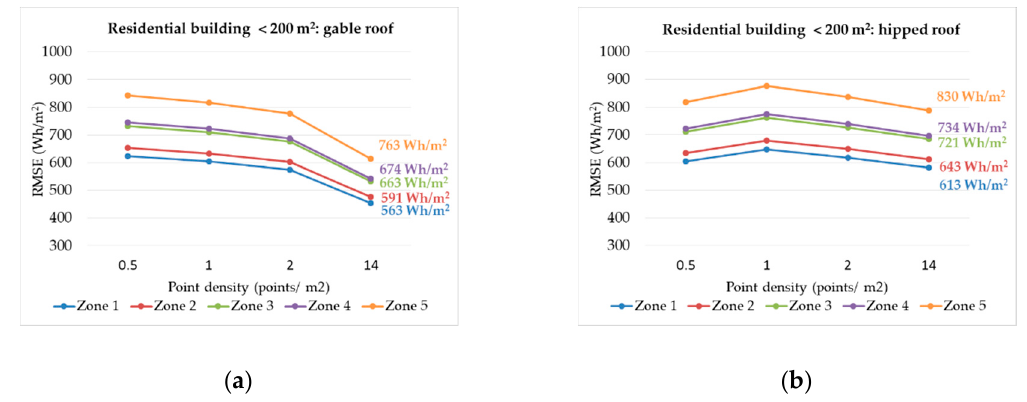
Figure 16. Average daily PV energy production per square meter loss (Wh / m 2 ) for residential buildings with an area smaller than 200 m 2 : ( a ) gable roof, ( b ) hipped roof.